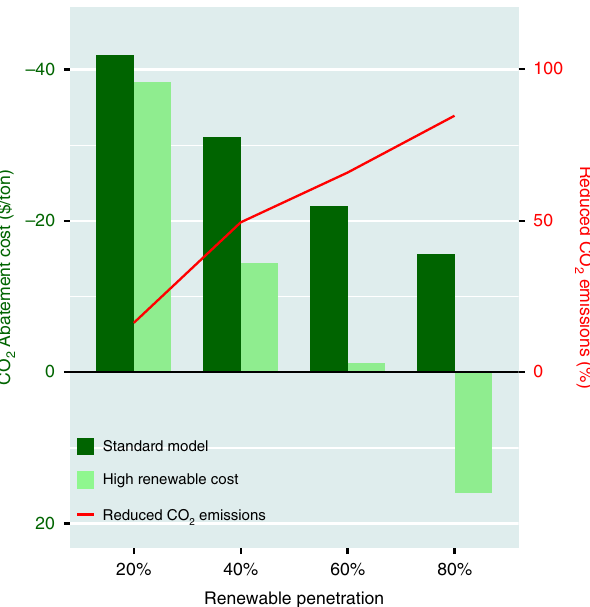
Fig. 6 CO 2 emissions reductions and costs. Costs for CO 2 emission reductions (in $/ton CO 2 ) obtained by comparing the cost per unit CO 2 at a given renewable penetration to the 0% renewable scenario. Negative costs denote an option where both system costs and CO 2 emissions are reduced. Dark green bars indicate the standard model (low renewable cost) scenario and light green bars represent the high renewable cost scenario. The red line denotes the percent reduction in CO 2 emissions associated with different renewable scenarios relative to the 0% renewable reference. For discussion of considerations used to derive costs, see